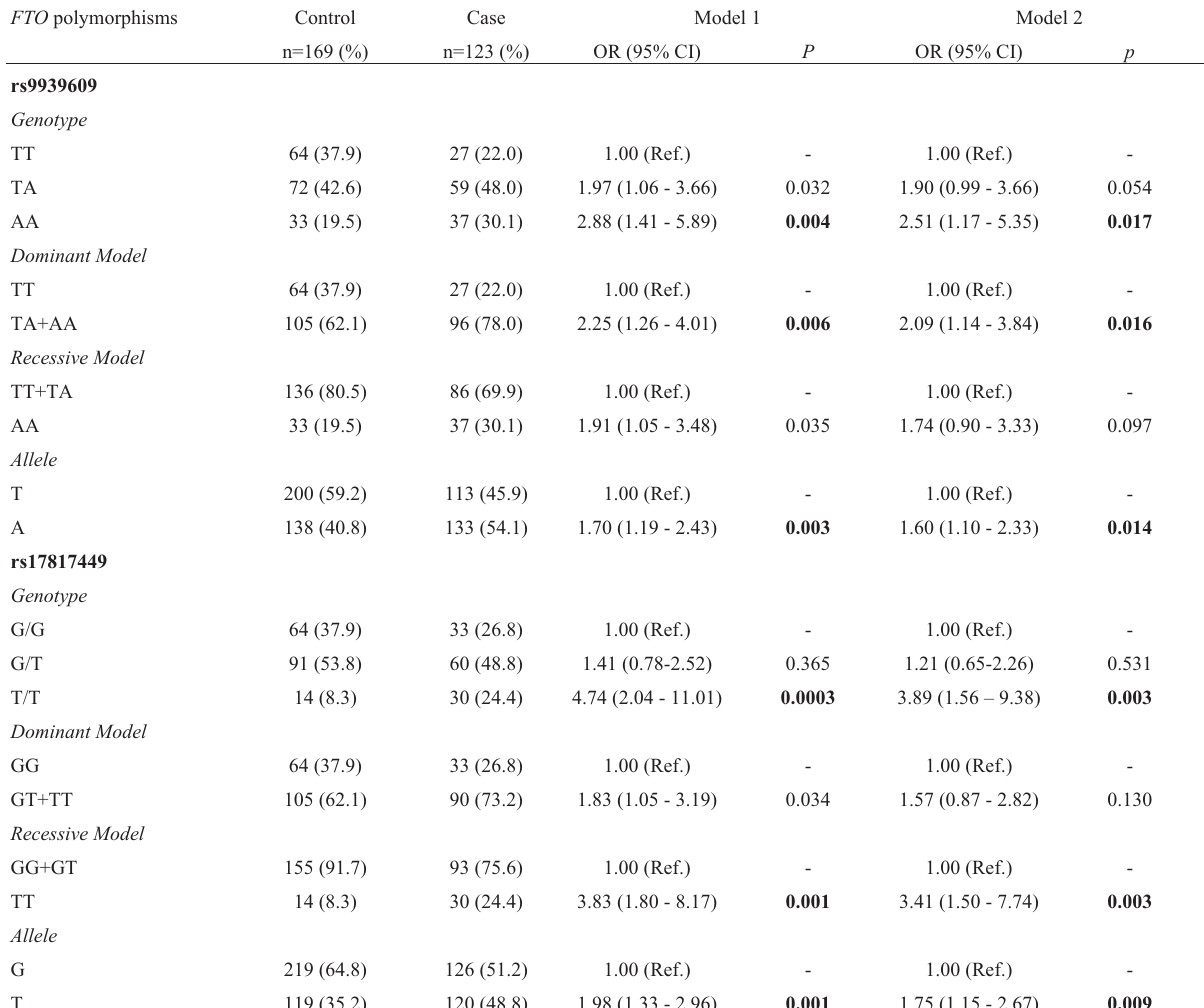
Table 2 - Genotypic and allelic frequencies of FTO rs9939609 and rs17817449 polymorphisms.